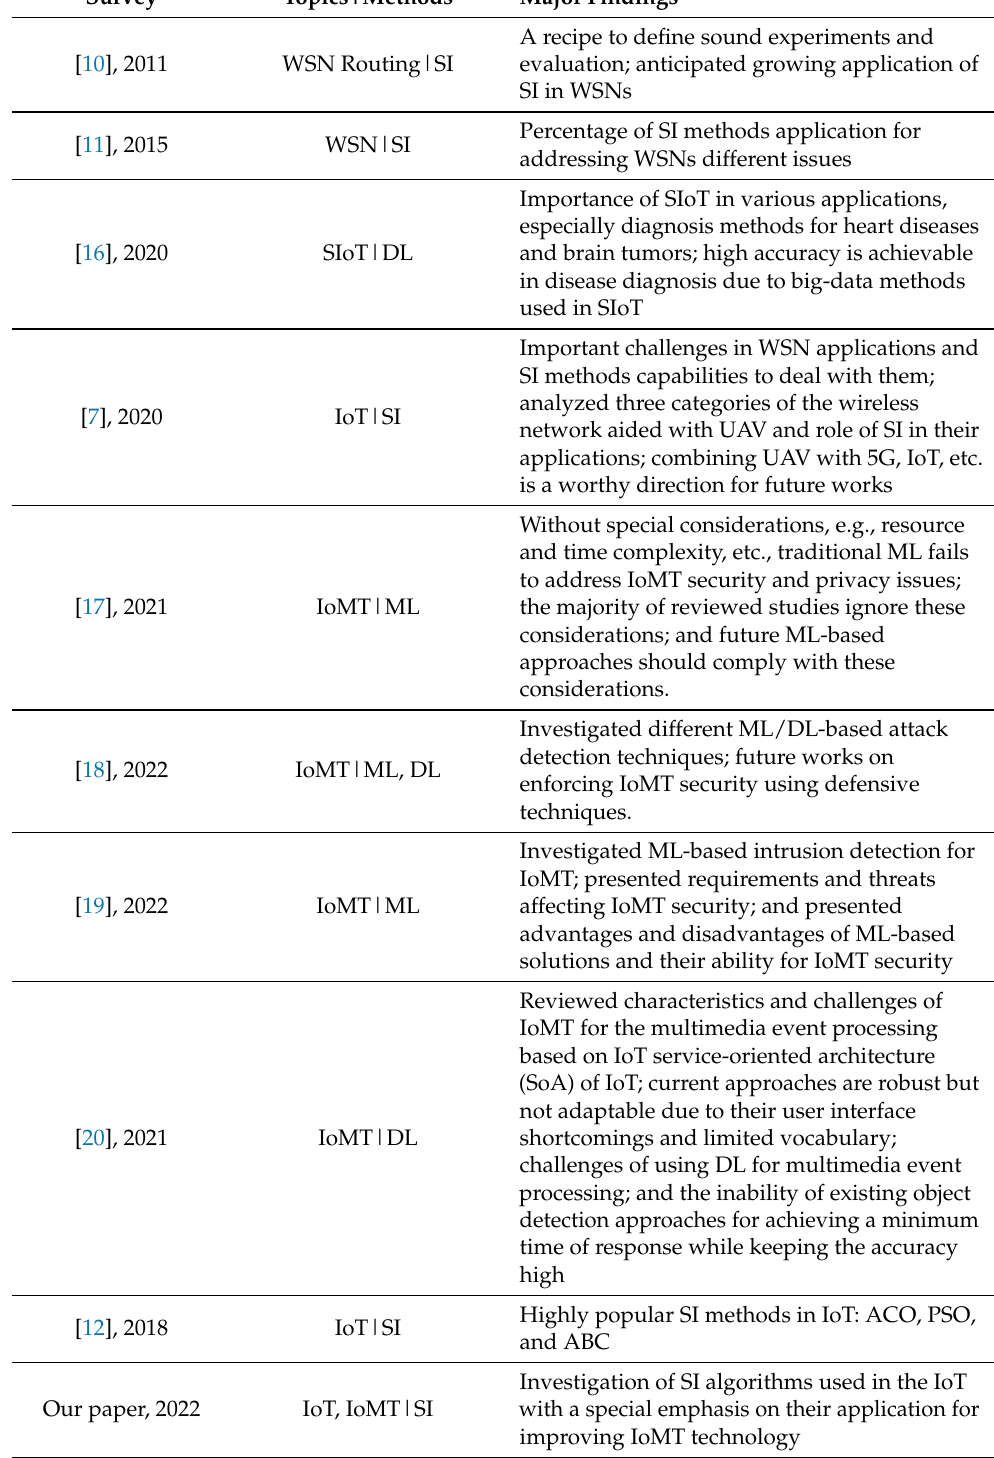
Table 1. Comparison with previous related